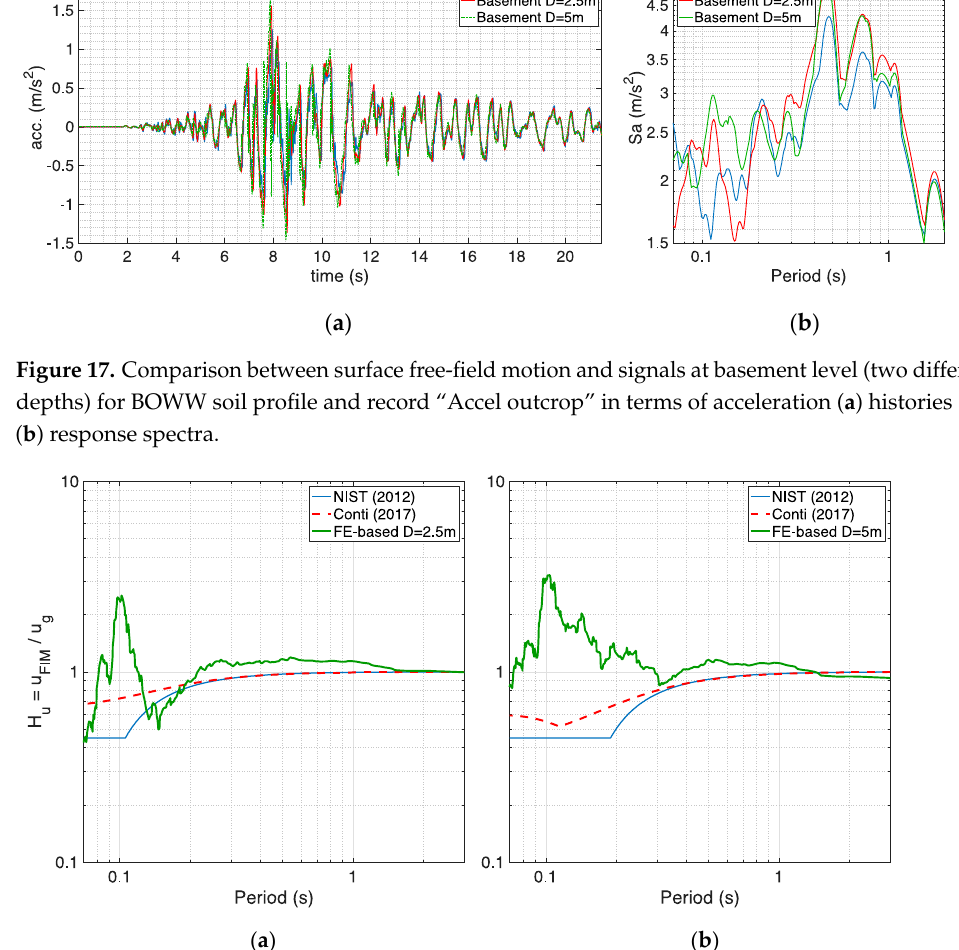
Figure 18. Comparison between analytical transfer functions obtained from two models and FE- based ones for embedment depths of ( a ) 2.5 m and ( b ) 5 m for BOWW soil profile and record “Accel outcrop”.